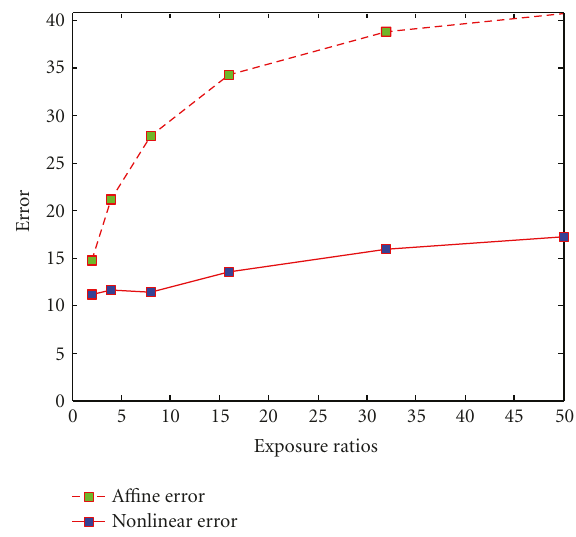
Figure 2: Root-mean-square error (RMSE) values of photometri- cally registered images with relative exposure rates of 2, 4, 8, 16, 32, 50. The RMSE values (green points) for a ffi ne mappings are 14.8, 21.1, 27.8, 34.3, 38.7, 40.7. The RMSE values (blue points) for non- linear mappings are 11.2, 11.6, 11.4, 13.5, 15.9,